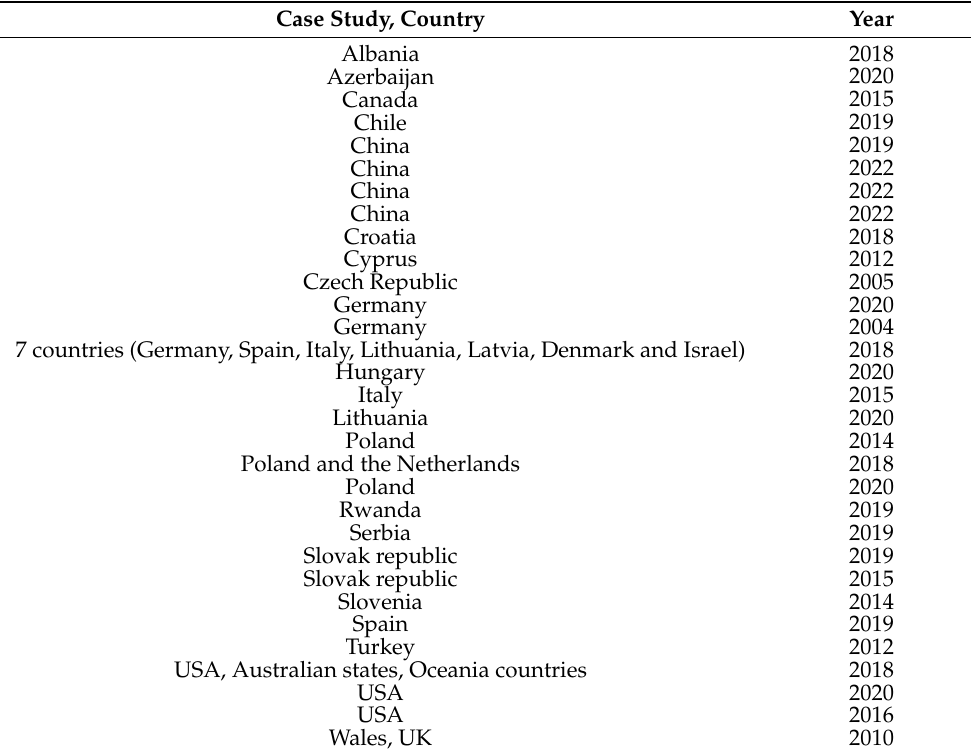
Table 3. Selected papers include case studies conducted in 24 countries